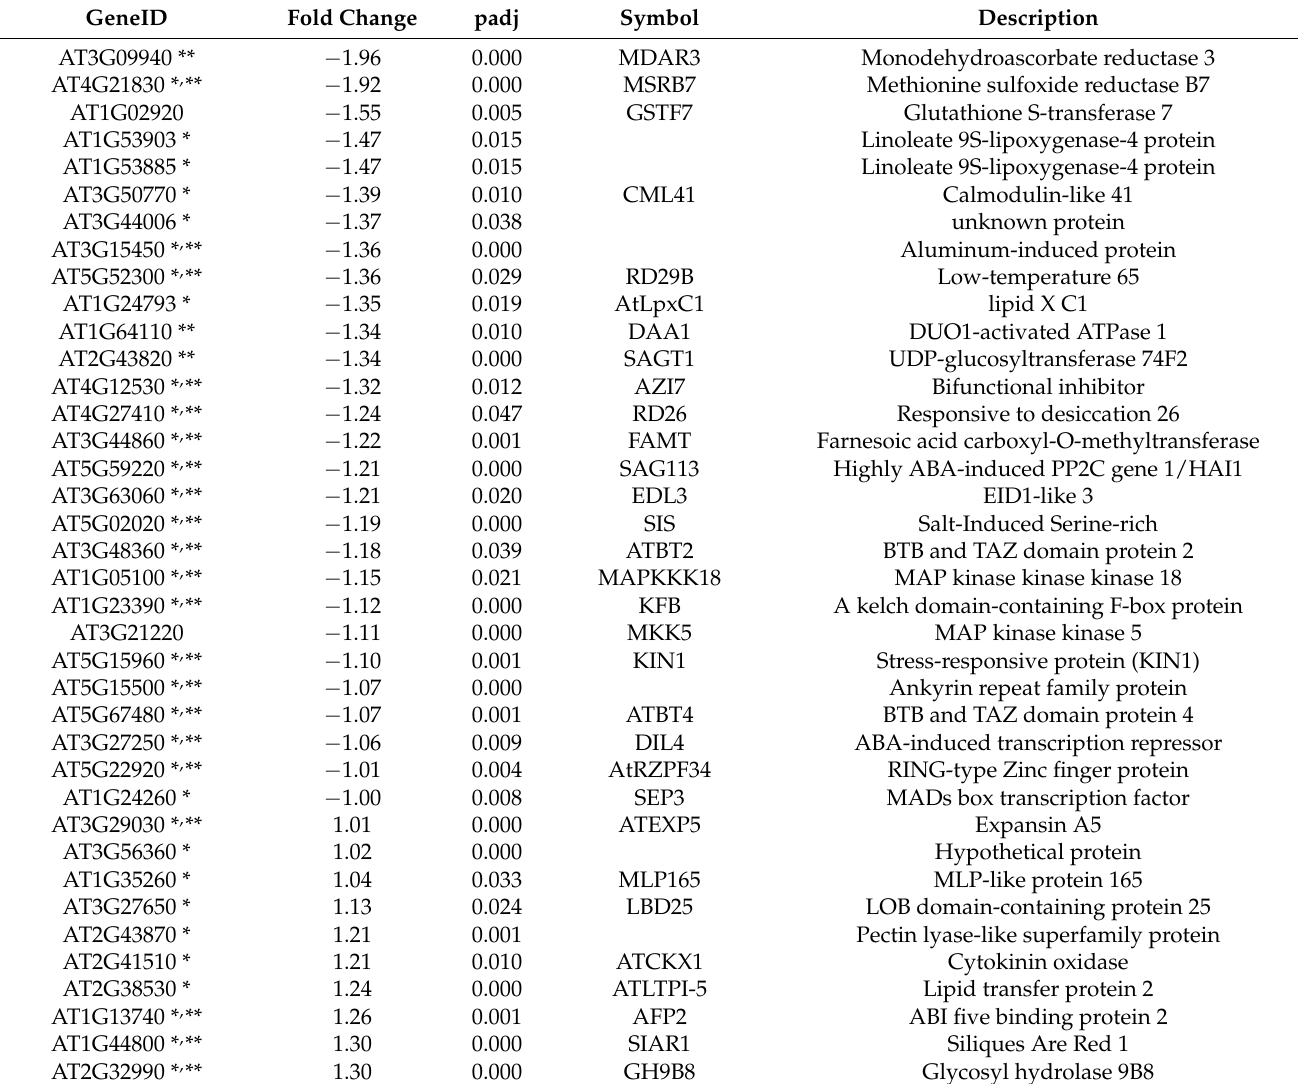
Table 1. Different expressed genes in 35S: SlCML39 compared to wild-type Arabidopsis thaliana under high temperature (padj < 0.05; |fold change| >